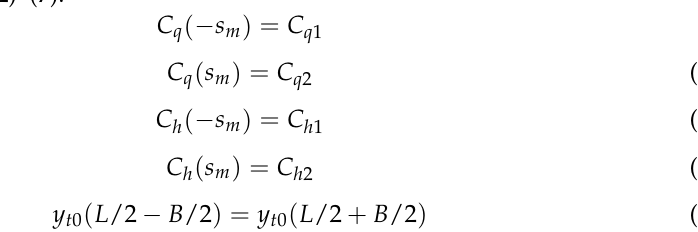
Figure 4. Quadratic gap crown and effective quartic crown of CVCplus.